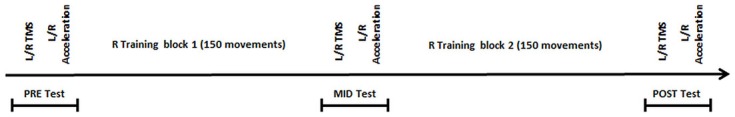
Experimental timeline. L = left; R = right.